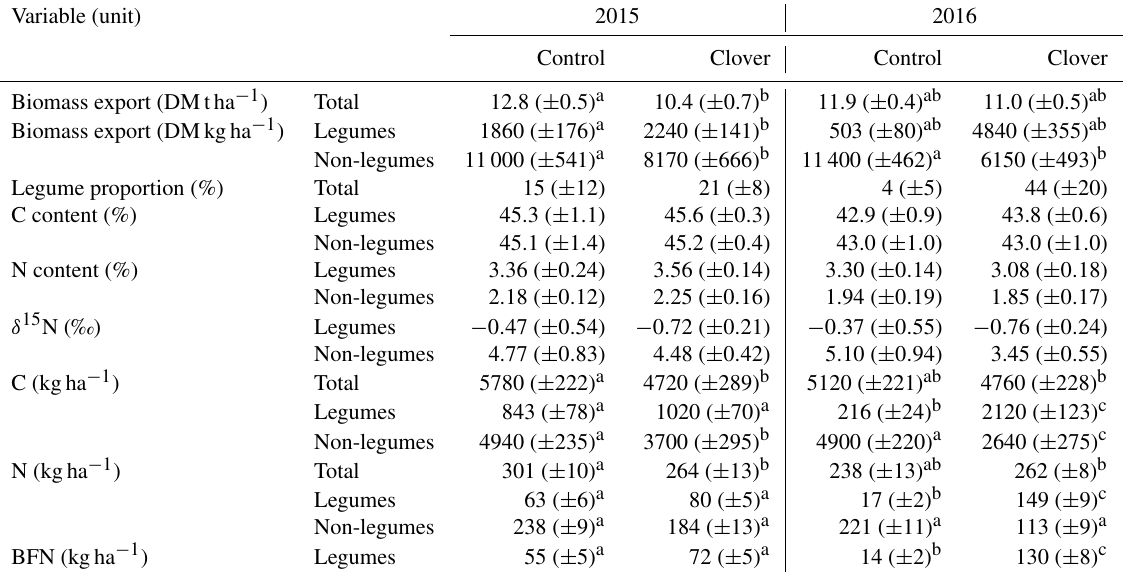
Table 2. Characteristics of the exported biomass from the control and clover parcels in 2015 and 2016 for legumes, non-legumes, and total biomass (legumes and non-legumes). Numbers in brackets give the respective standard errors. The legume proportion is based on the annual biomass exported. C and N content and δ 15 N values refer to mean values across all samples. BFN refers to N derived from the atmosphere in harvested clover biomass. Means sharing the same superscript (per row) are not significantly different from each other (Tukey’s HSD, p < 0 . 05); no significance tests were applied for percentages and